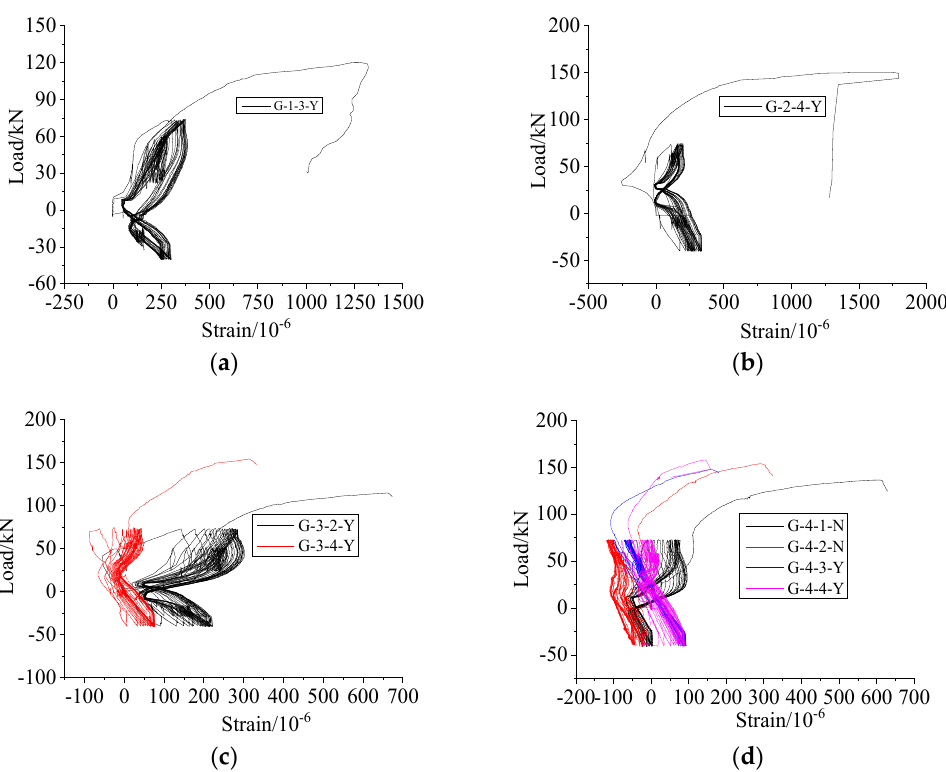
Figure 22. Load–hoop strain curves for the middle section of the sleeve near the steel bar under repeated high-stress tension and compression loading (SH3). ( a ) Group G − 1, ( b ) Group G − 2, ( c ) Group G − 3, ( d ) Group G − 4.